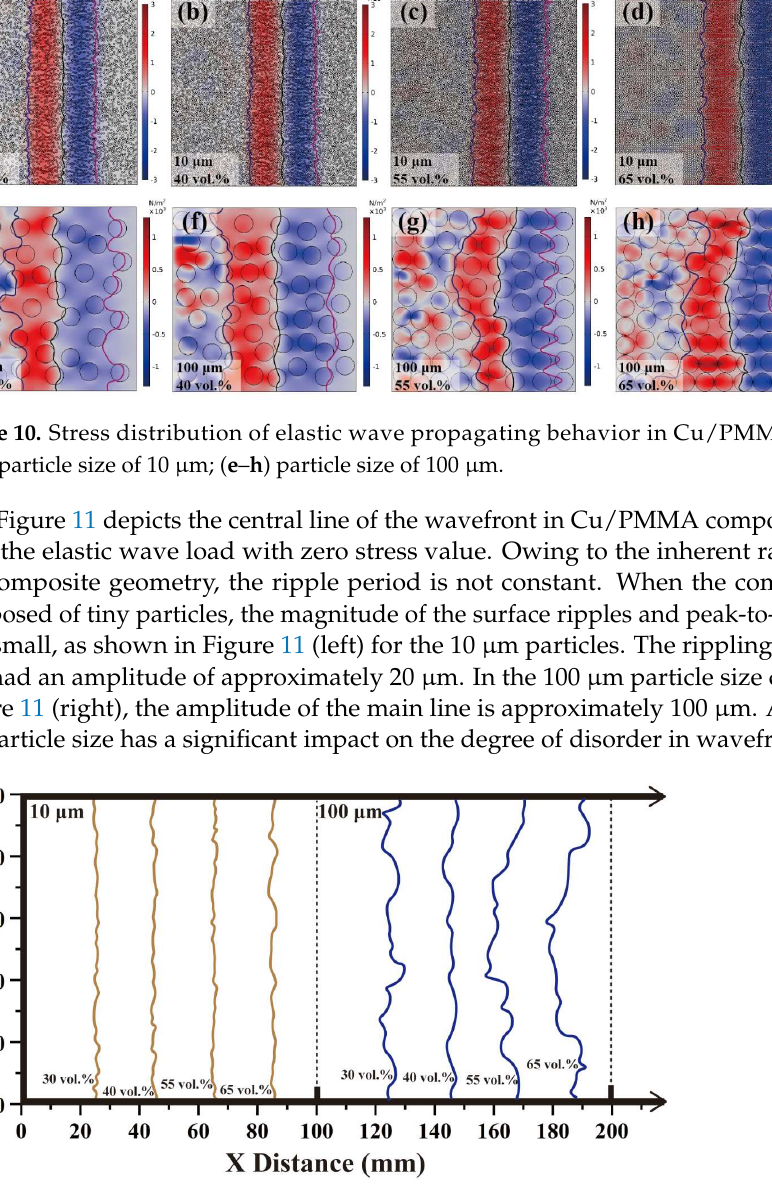
Figure 11. Central line of the wavefront from simulations after elastic wave load for 40–60% volume fraction of 10 µm ( left ) and 100 µm ( right ) in Cu/PMMA.